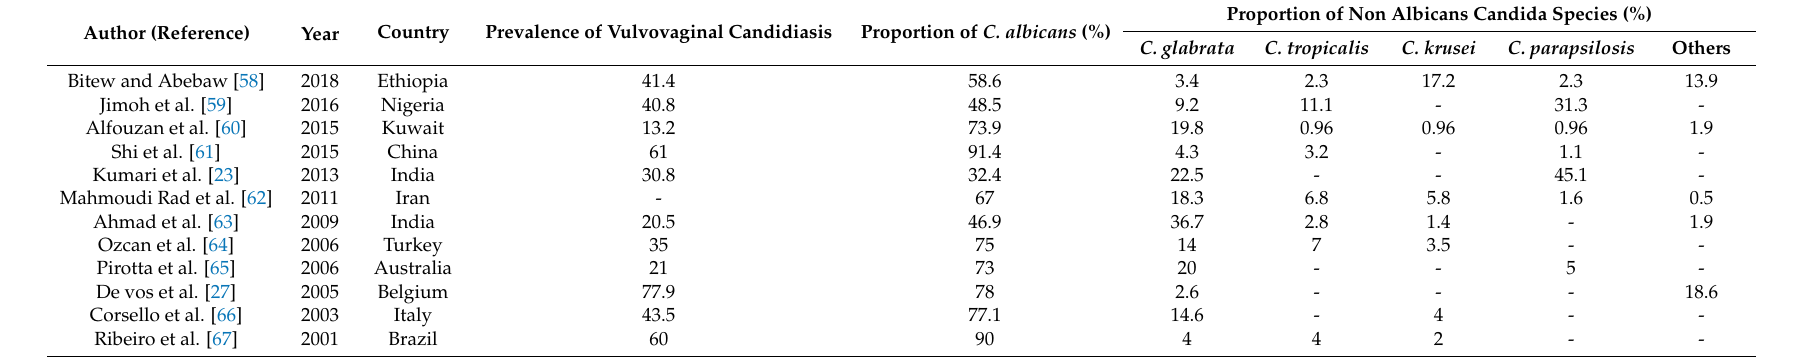
Table 1. Epidemiology of non albicans vaginal